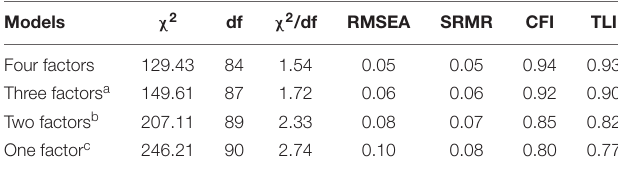
TABLE 2 | Confirmatory factor analysis